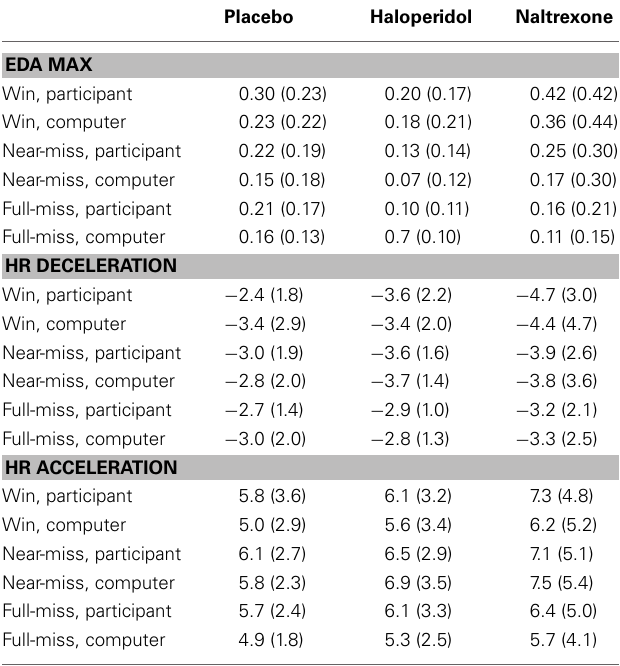
Table 3 | Psychophysiological responses to outcomes on the slot machine task (change scores from